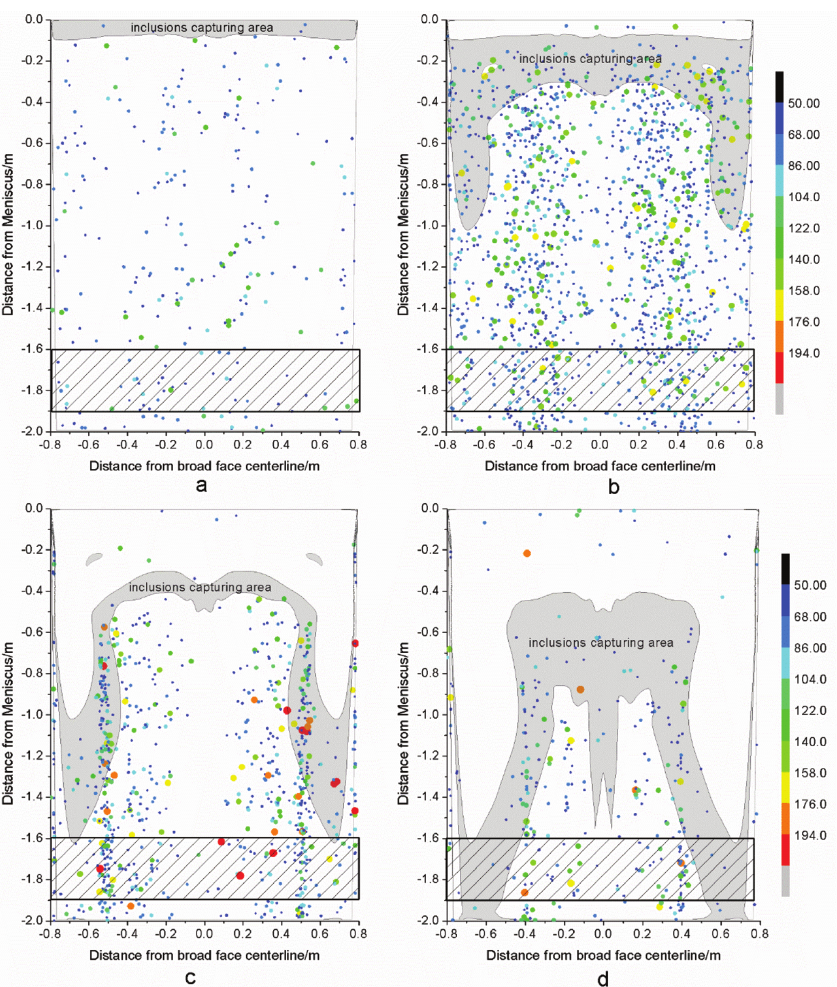
Figure 10: Inclusion distributions at different depths taking into account the effect of the PDAS: 0~0.01m from broad surface (a) 0.01~0.02m from broad surface (b) 0.02~0.03m from broad surface (c) 0.03~0.04m from broad surface